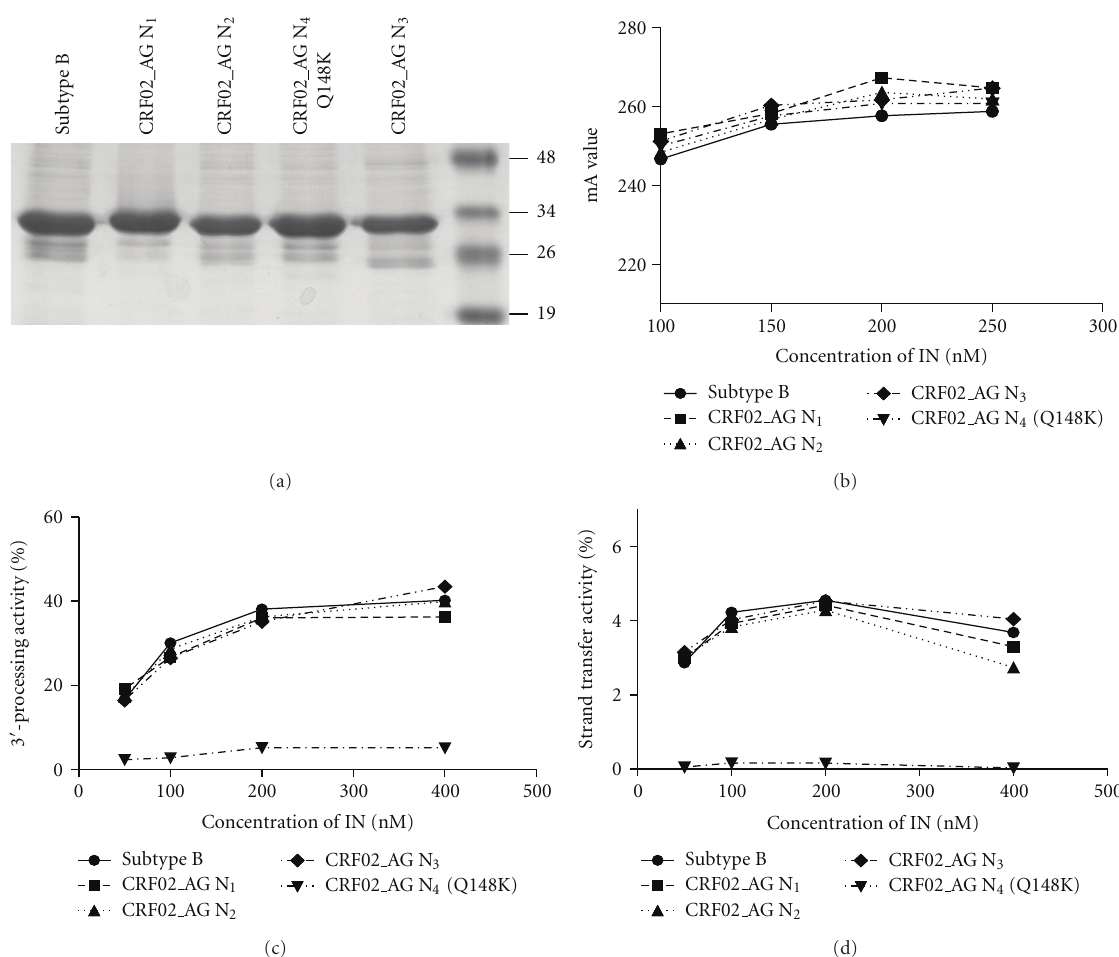
Figure 2: Purification of recombinant HIV-1 INs from B and CRF02 AG subtypes and comparison of their activities. (a) Purification products N 1 , N 2 , N 3 and N 4 of recombinant HIV-1 INs from B and CRF02 AG subtypes. (b)–(d) Comparison of DNA binding, 3 (cid:2) -processing and strand transfer activities, respectively, of the HIV-1 IN from B and CRF02 AG as a function of IN concentration. − 7.42 kcal/mol while those obtained with AutoDock range from − 8.72 to − 6.65 kcal/mol. Scores obtained for a